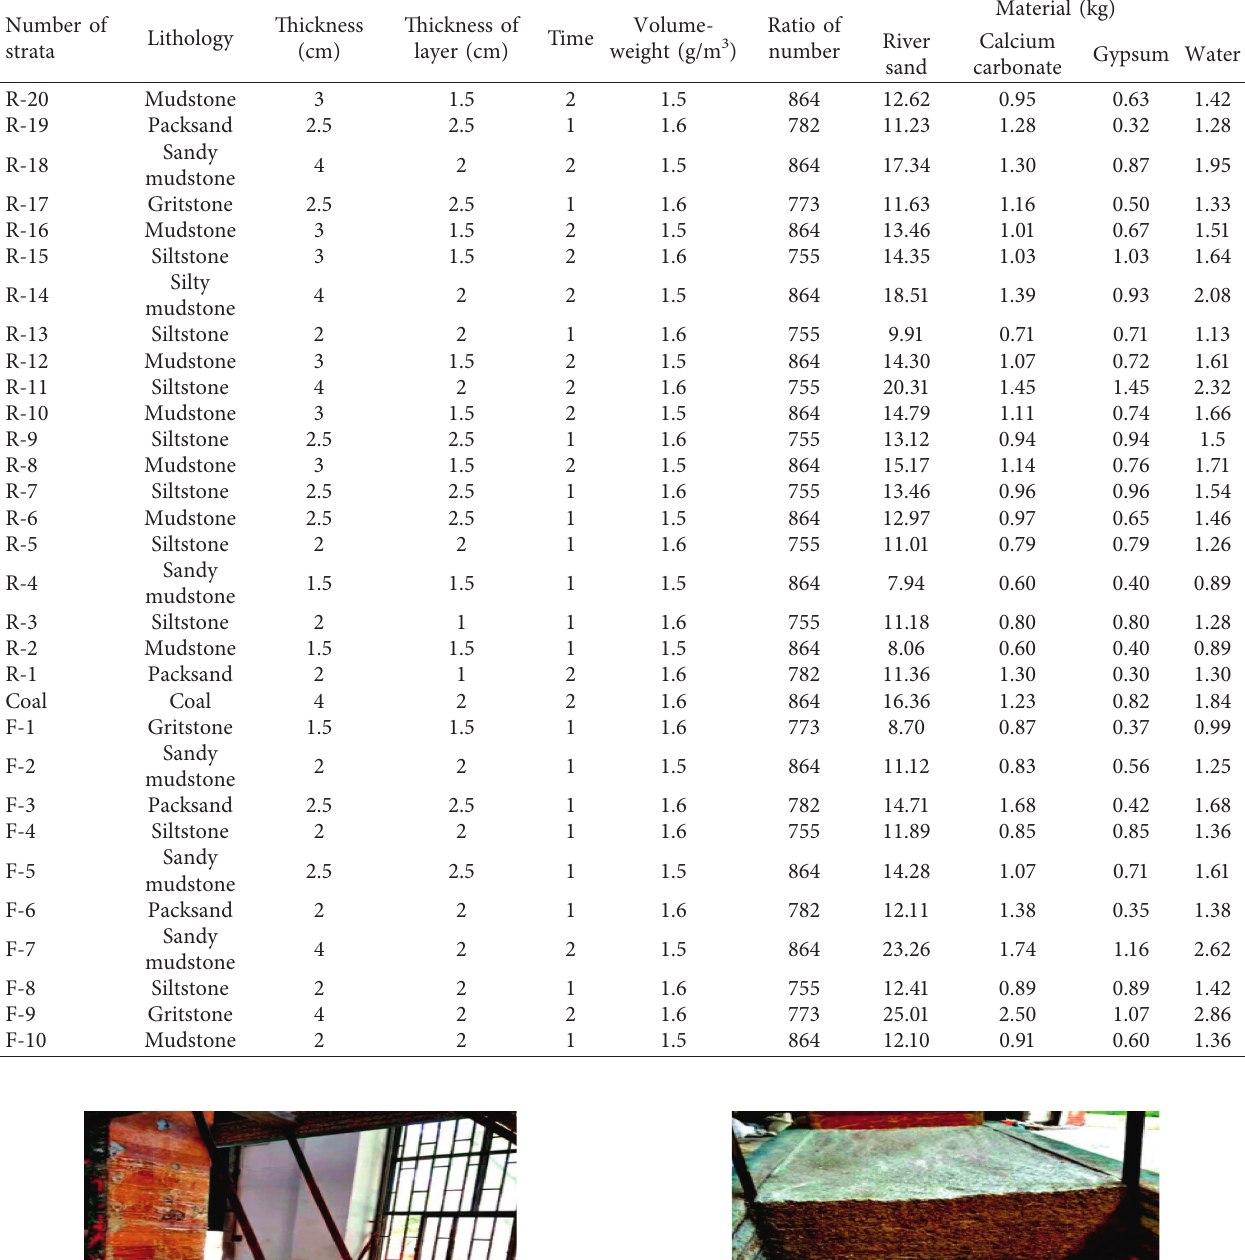
Table 2: Ratios and dosages of similarly simulated materials.